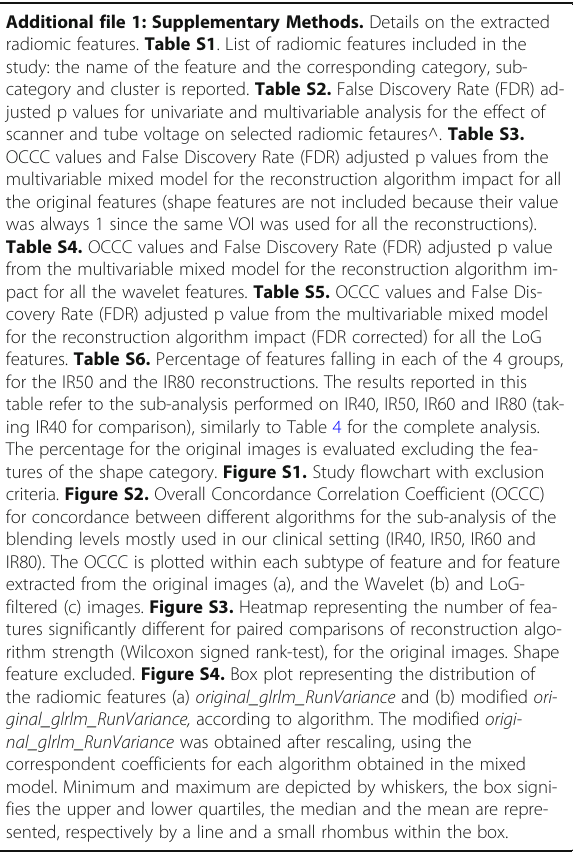
applied before redundancy reduction and correlation analysis with clinical endpoints.